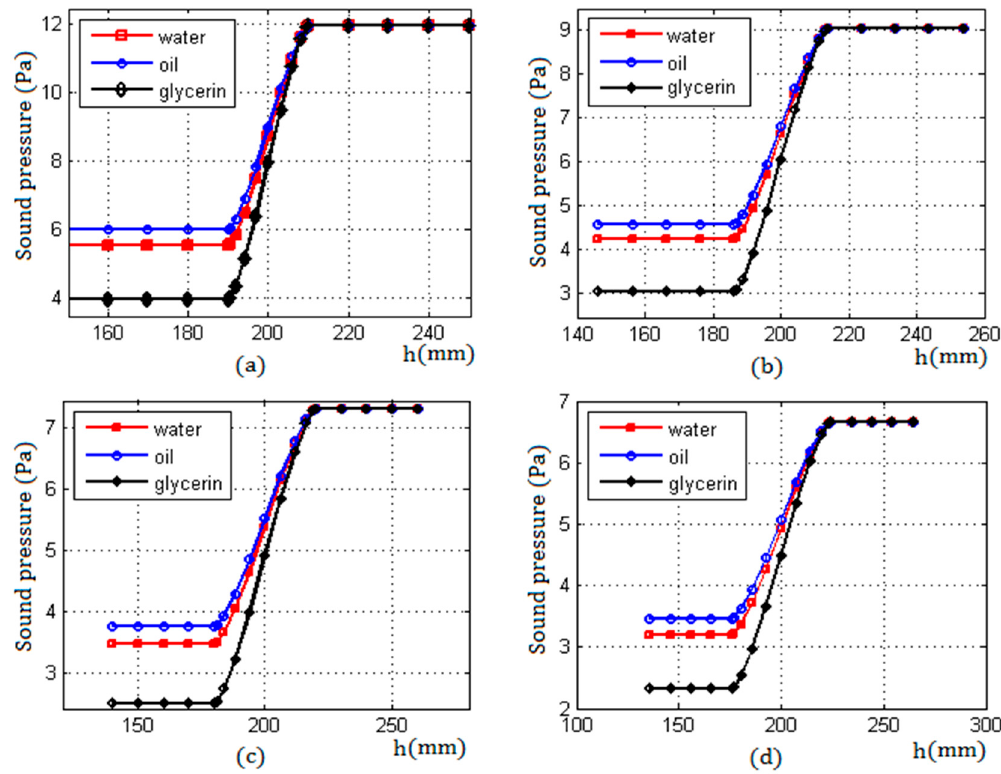
Figure 10. The echo sound pressure of three kinds of liquid media with different ultrasonic impedance calculated under different wall thicknesses; the abscissa axis h represents the scale value of the container height. ( a ) L = 8 mm; ( b ) L = 25 mm; ( c ) L = 40 mm; and ( d ) L = 50 mm.